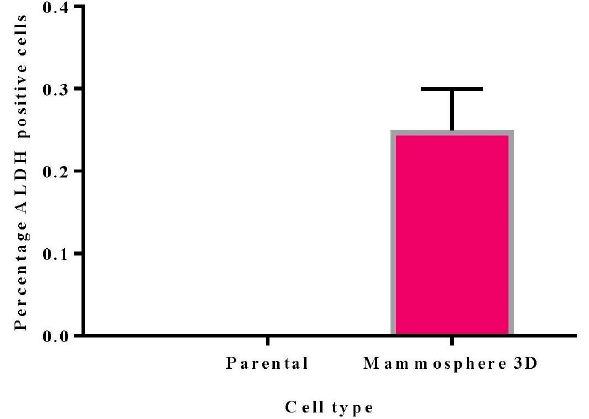
Figure 3. Graphical representation and flow cytometry analysis results of expression of CD44 and CD24 surface markers in parental and 3D mammosphere cells: 92% 3D mammosphere cells are CD44+CD24-/low and 70% parental cells.